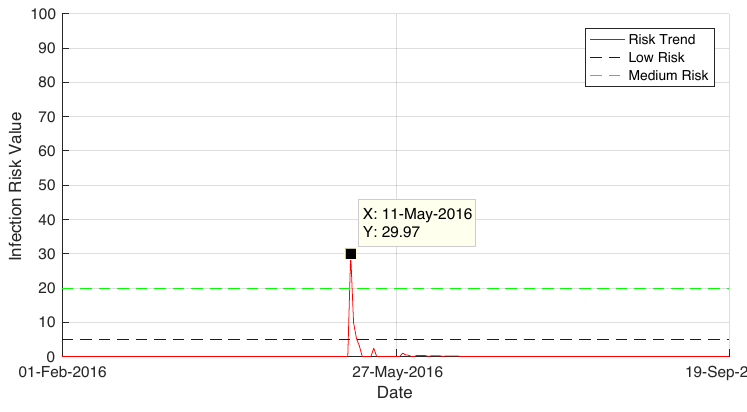
Figure 15. Risk of infection evaluated at the San Michele External position using weather data coming from San Michele weather station data and extending the leaf wetness data using the MLP technique at the geographical position of San Michele External. This risk evaluation differs from the one acquired in San Michele.